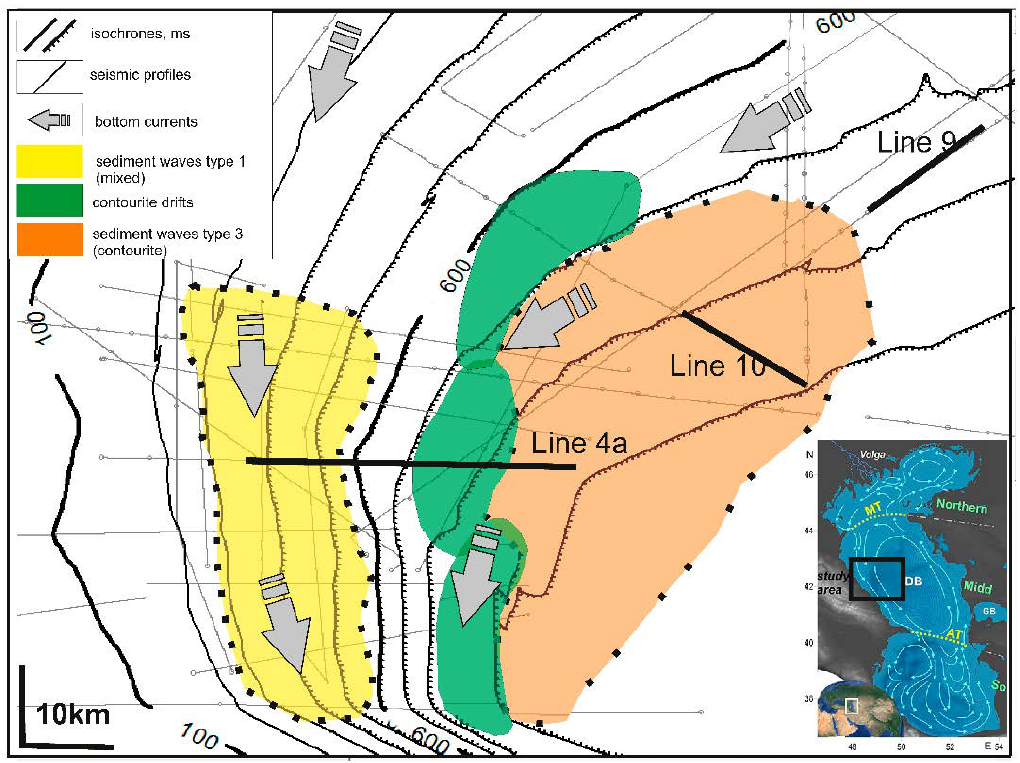
Figure 7. Contourite deposits near the western slope of the Middle Caspian Sea. Location in insert. Arrows for near bottom water currents. Lines 4a, 9, and 10 show the positions of the seismic profiles shown in the corresponding figures.